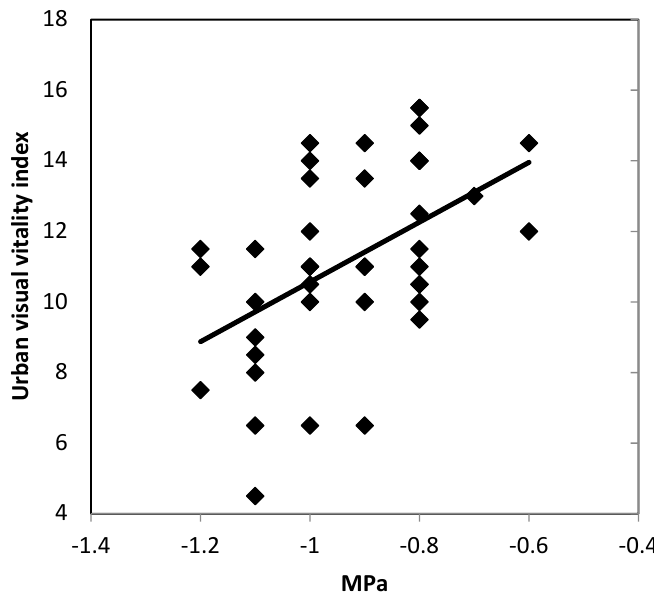
Figure 5. Summer pre-dawn water potential versus urban visual vitality index in Platanus × acerifolia . Trend line = linear regression, p = 0.001, r 2 = 0.240, n = 40.